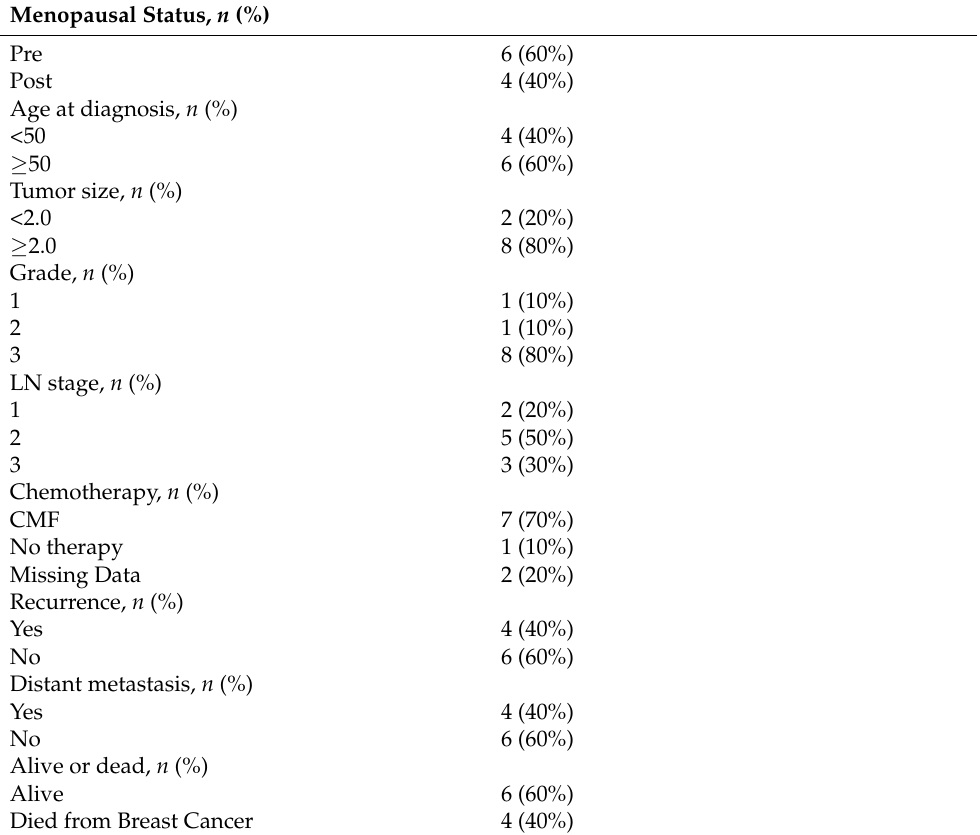
Table 1. Clinicopathological characteristics of